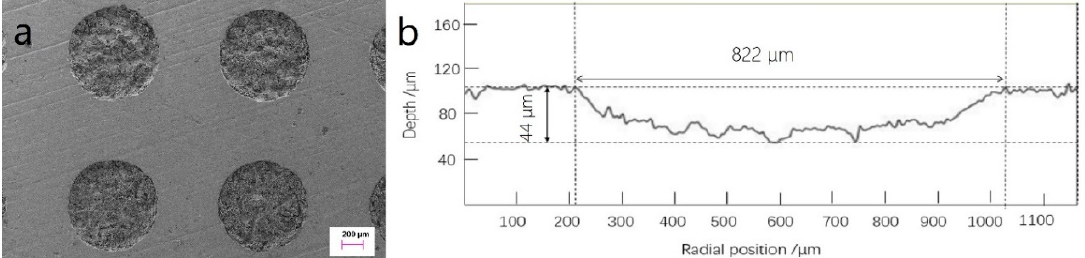
Figure 3. Surface topography of micro-dimpled cylinder liner ( a ) and two-dimensional (2D) profile of single micro-dimple ( b ).